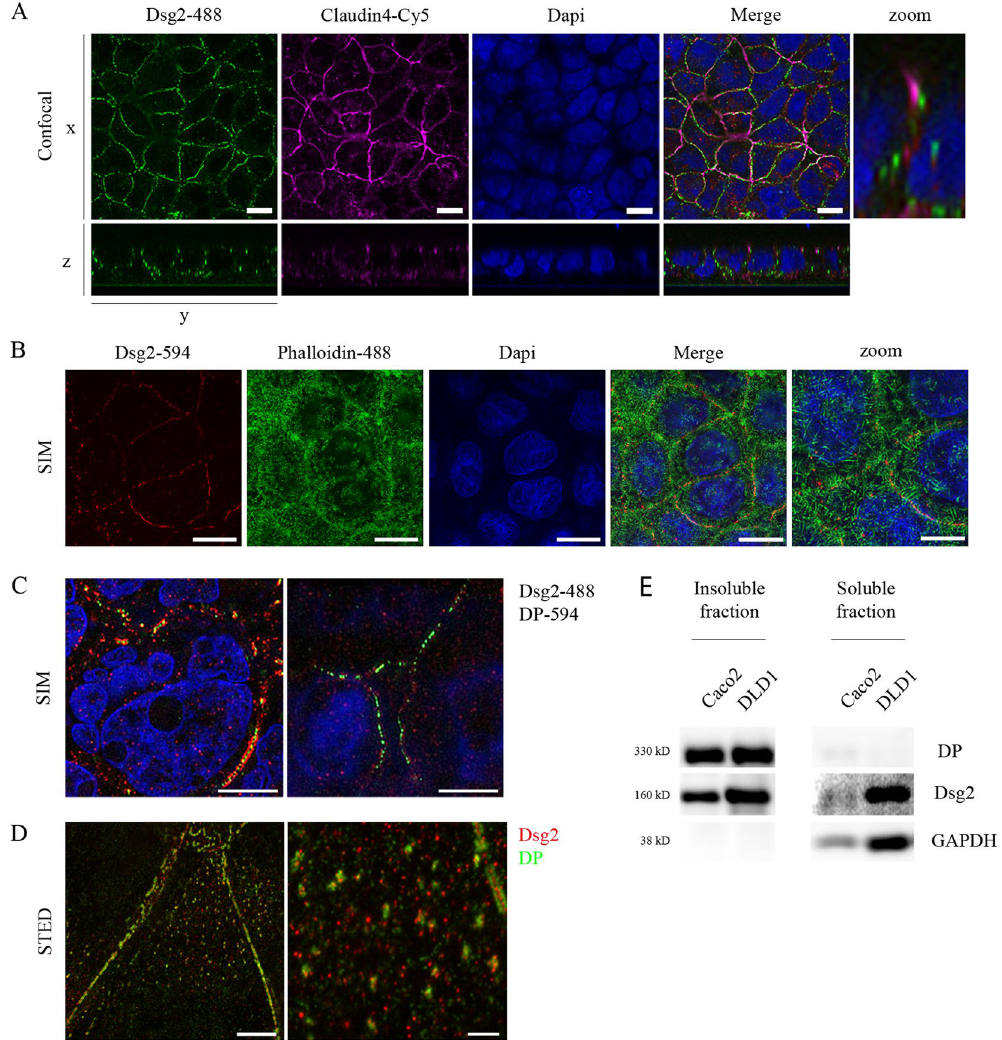
Figure 1. Extradesmosomal Dsg2 is present at the cell surface of polarized cultured enterocytes. Cells were grown on coverslips for several days after reaching confluency, fixed with 2% PFA and stained for junctional components. ( A ) Confocal microscopy analysis of Caco2 cells shows linear and apical localization of the junctional components Dsg2 and Cld4 at cell borders. Scale bar, 10 µ m. ( B ) Analysis with SIM shows Dsg2 being located at same level as microvilli, visualized with Alexa488-phalloidin, at the surface of Caco2 cells. Shown is a Z-projection. Bar, 5 µ m. ( C ) Apical fraction of Dsg2 (right panel) is not co-localizing with DP in contrast to lower layers (left panel) where both can be found in close proximity as analysed via SIM. Scale bar, 5 µ m. ( D ) Both, clusters consisting of Dsg2 and DP as well as single Dsg2 molecules are present on the cell surface of DLD1 cells, as revealed by STED. Scale bar, 5 µ m (left panel), 1 µ m (right panel). ( E ) Dsg2 was detected in both, the Triton X-100-soluble and -insoluble fraction in contrast to DP being present only in the insoluble fraction. GAPDH served as loading control. Cropped blots are displayed and full-length blots are included in the supplementary